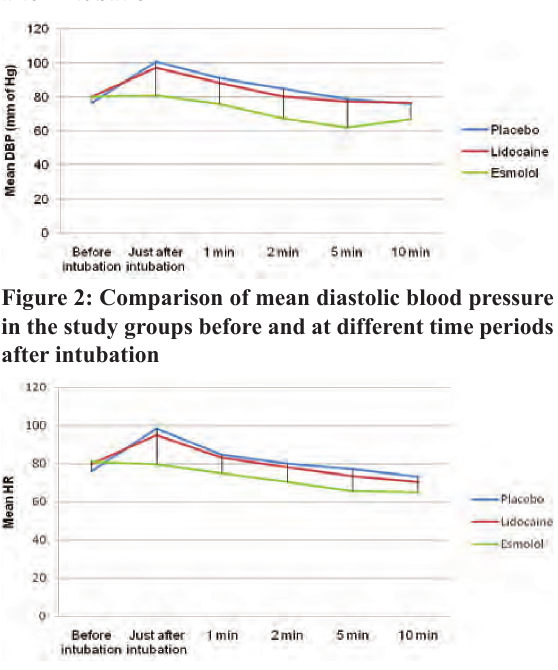
Figure 3: Comparison of mean heart rate in the study groups before and at different time periods after